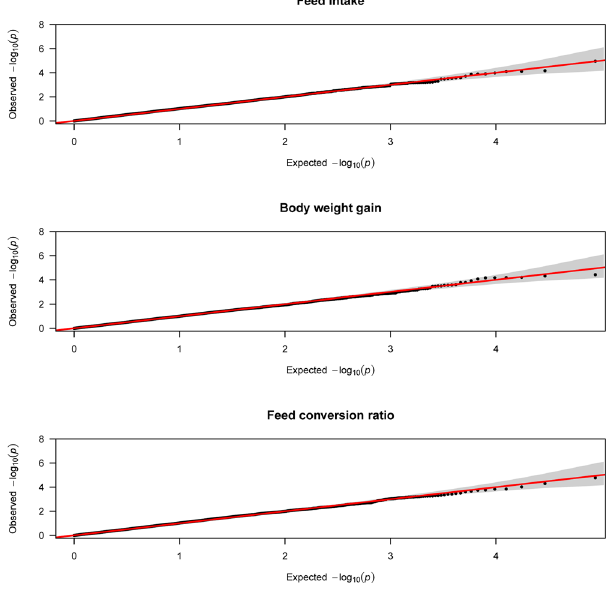
Figure 4. Quantile-quantile plots of feed efficiency traits using mixed linear model approach.